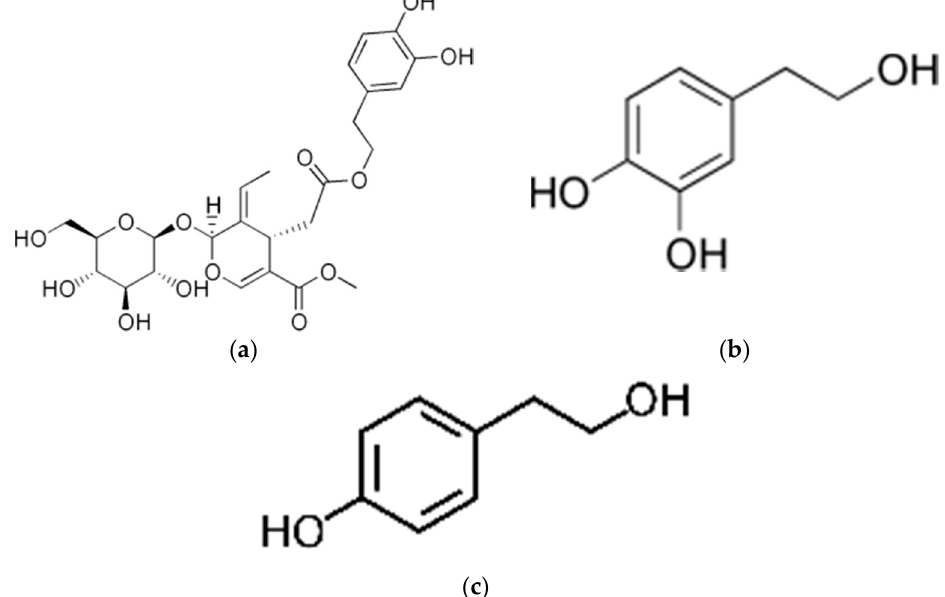
Figure 1. Chemical structure of ( a ) oleuropein, ( b ) hydroxytyrosol, and ( c ) tyrosol.